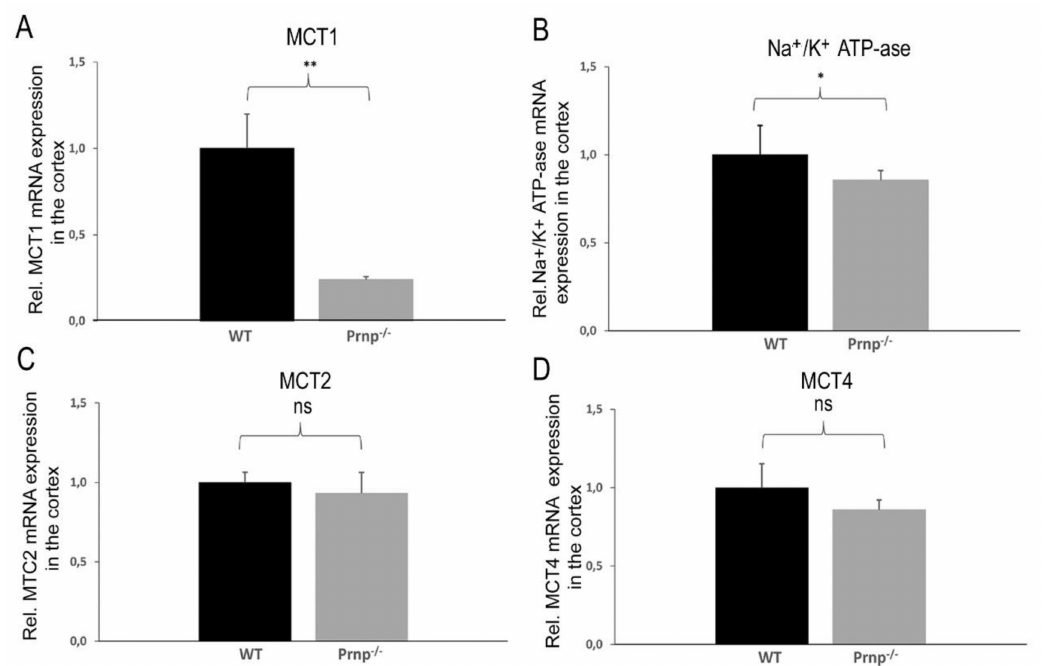
Figure 1. ( A – D ). Differential mRNA expression levels of monocarboxylate transporters MCT1 , MCT2 , MCT4 and Na + /K + ATP-ase α 2 subunit in the cortex of WT and Prnp − / − mice. qRT-PCR analysis revealed a significant decrease in MCT1 and Na + /K + ATP-ase α 2 subunit expression in the cortex tissue of Prnp − / − as compared to a control group. Sample size of WT group: n = 5; Prnp − / − group: n = 6. Displayed are means ± SEM. A p -value < 0.01 is considered as very significant (**), <0.05 as significant (*) and ≥ 0.05 as not significant (ns).